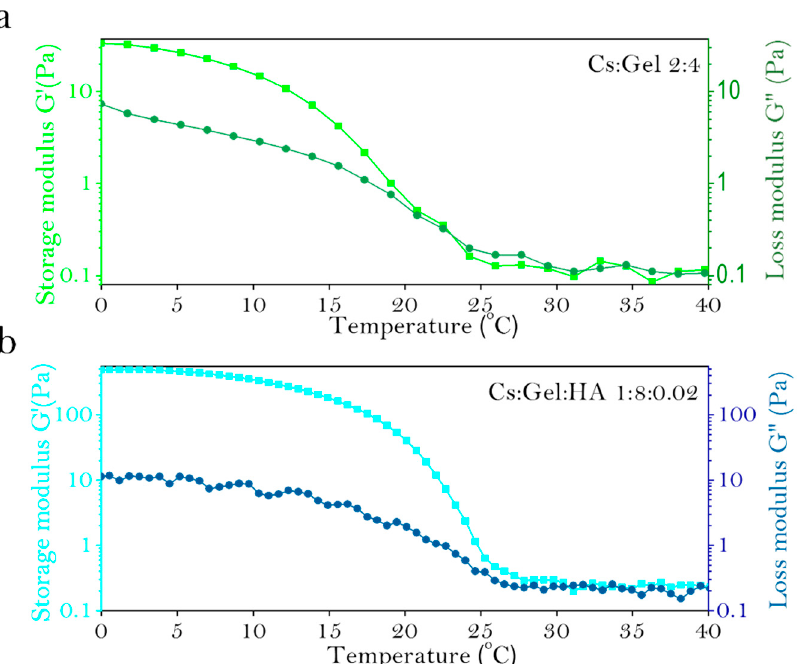
Figure 3. Gel point for various preparations of Cs:Gel:HA bio-ink, ( a ): Cs:Gel = 2:4, ( b ): Cs:Gel:HA = 1:8:0.02. Table 5 . Summary of fluid properties of various ratios of bio-ink.